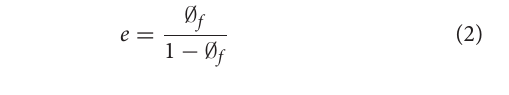
TABLE 1 | Mechanical properties of the patient-specific poroelastic finite element model. Spinal